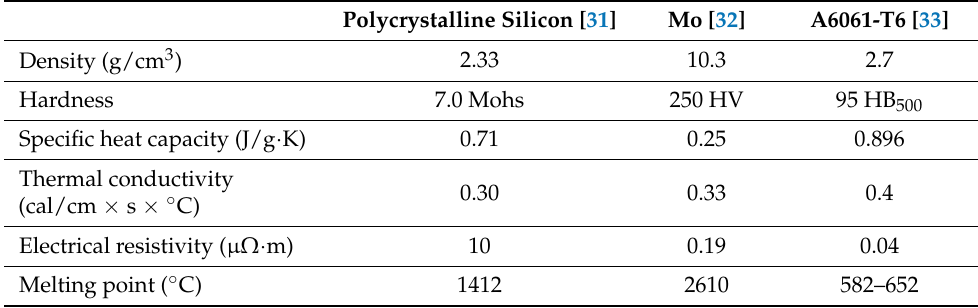
Figure 3. Set-ups for: ( a ) silicon workpiece sandwiched with assisting electrodes; ( b ) material removal and surface modification process; ( c ) synchronized surface modifications during wire electrical discharge machining; ( d ) wave form data acquisition in WEDM. Table 2. Properties of target workpiece, wire electrode, and assisting electrode material [31 – 33].